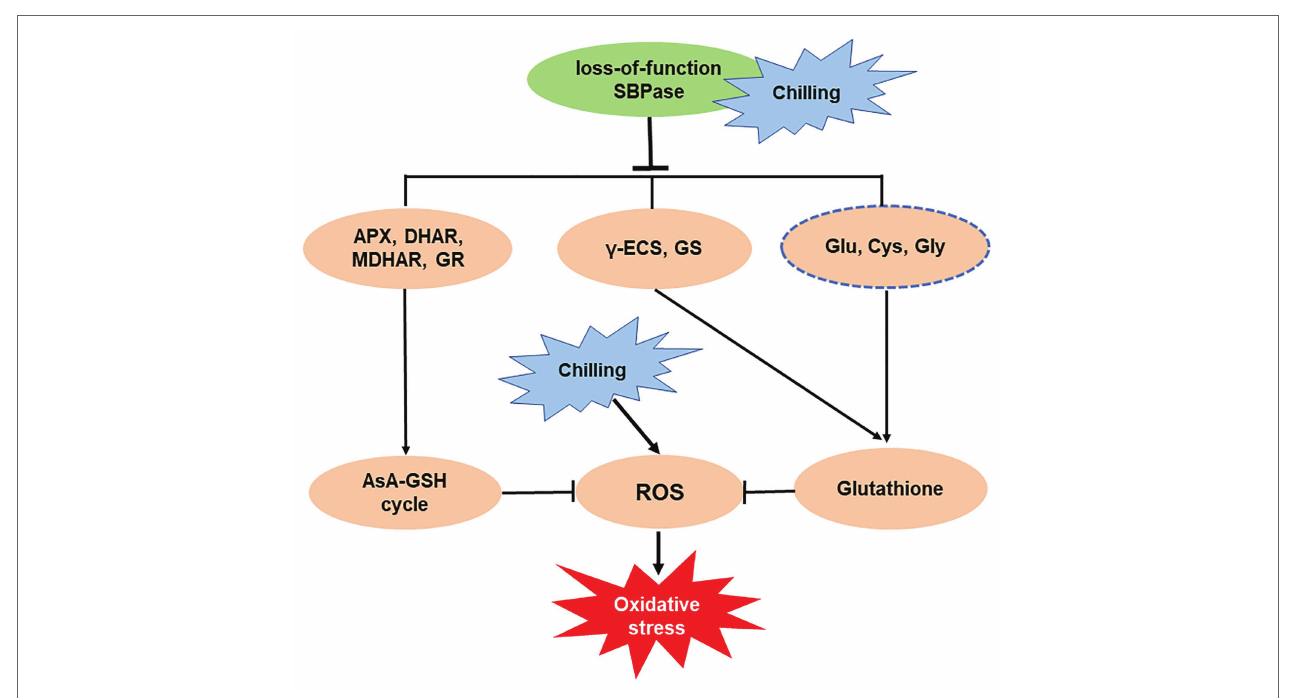
FIGURE 8 | Simplified schematic representation of the importance of sedoheptulose-1,7-bisphosphatase (SBPase) in the mitigation of oxidative stress triggered by low